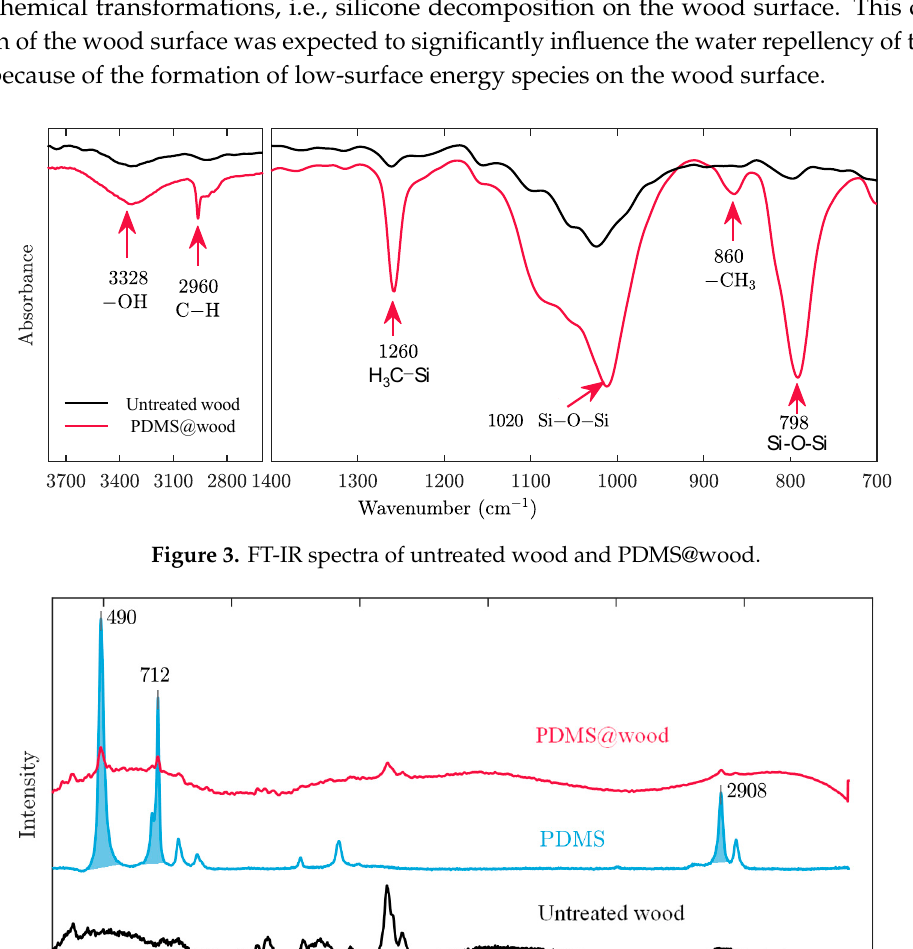
Figure 3. FT-IR spectra of untreated wood and PDMS@wood.